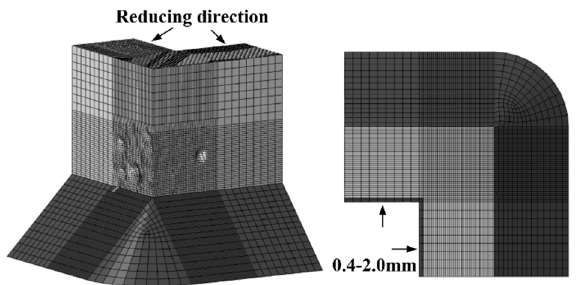
Table 5. Results of simulation of ultra-low cycle fatigue (ULCF) crack-initiation life of corroded steel bridge piers.